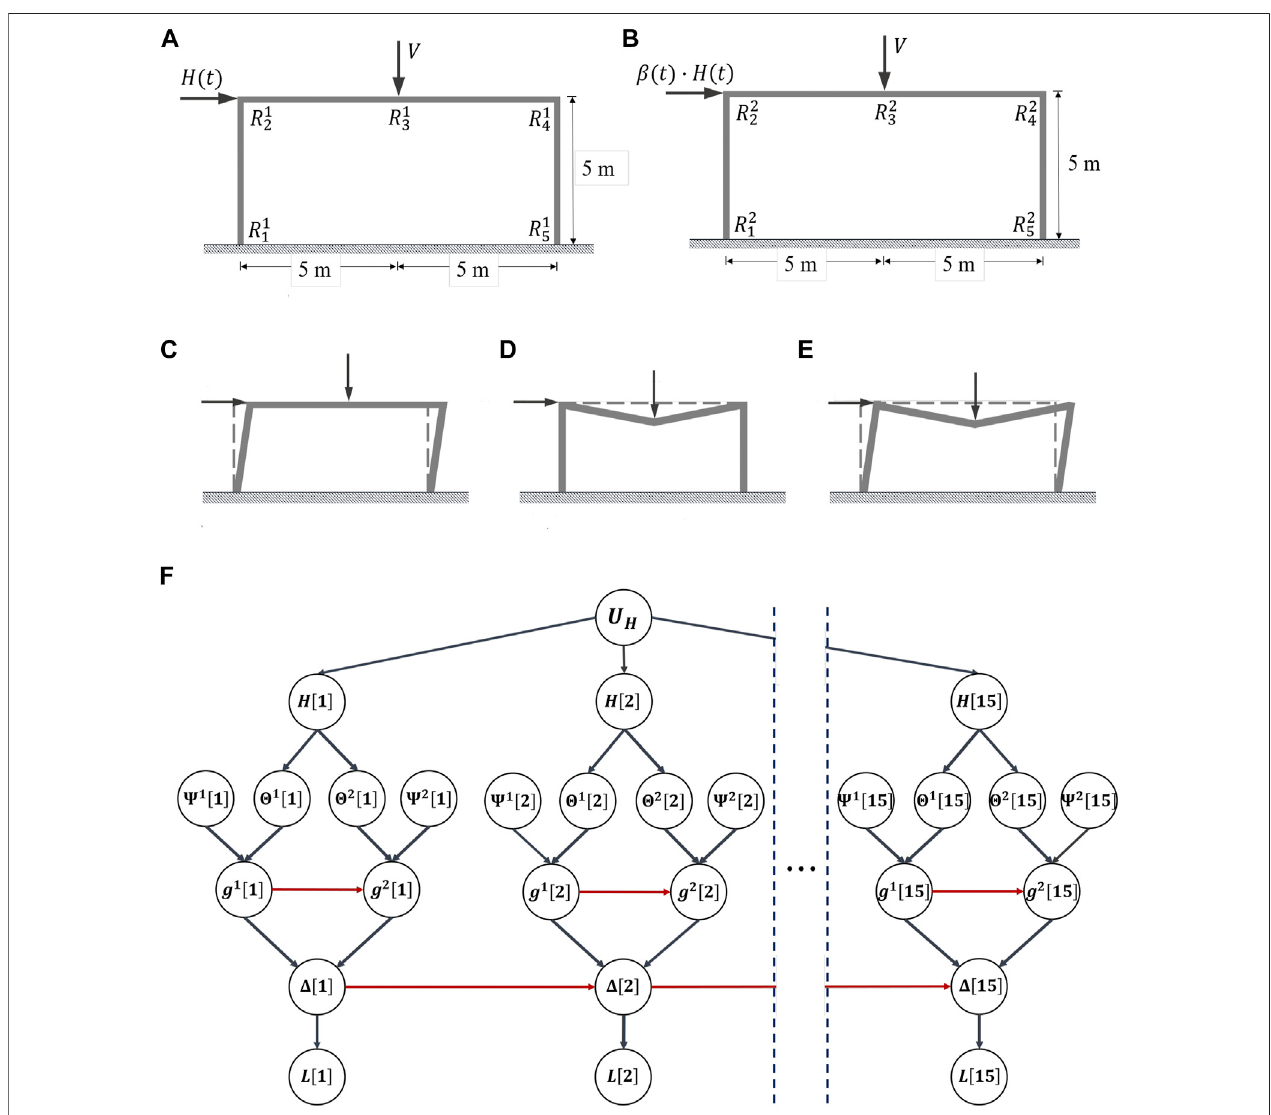
FIGURE 10 | Typical single-bay elastoplastic frame model adapted from (Der Kiureghian, 2005; Straub and Der Kiureghian, 2010). In the two-frame system, each frame is subjected to vertical V and time-varying horizontal H ( t ) loads. (A) Frame 1, (B) Frame 2 is subjected to an additional horizontal load as a result of the structural failure of Frame 1. Three different structural failure mechanisms are considered: (C) sway mechanism, (D) beam mechanism, and (E) combined mechanism. (F) DBN model for the system of two single-bay elastoplastic frames.